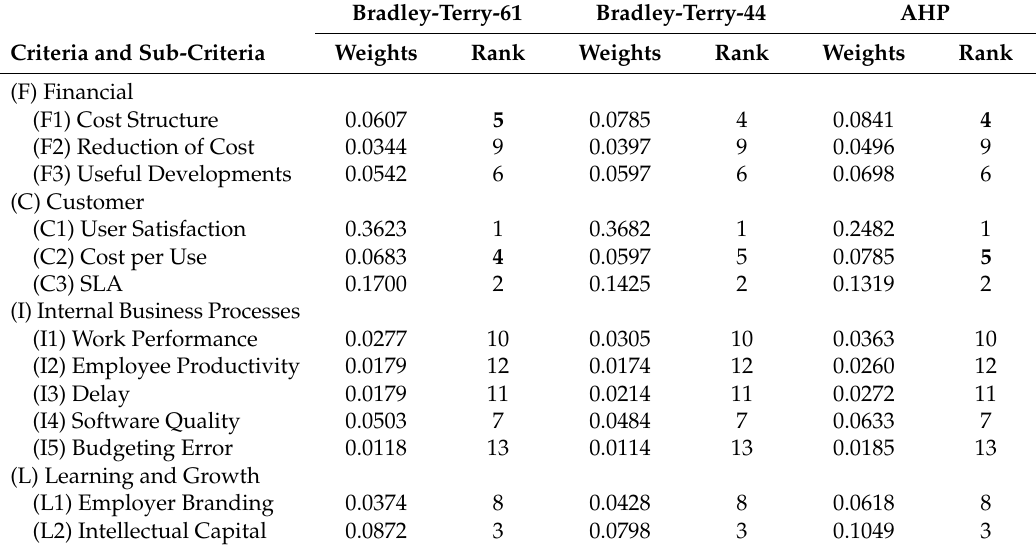
Table 13. Bradley-Terry overall weights and rank compared with AHP.